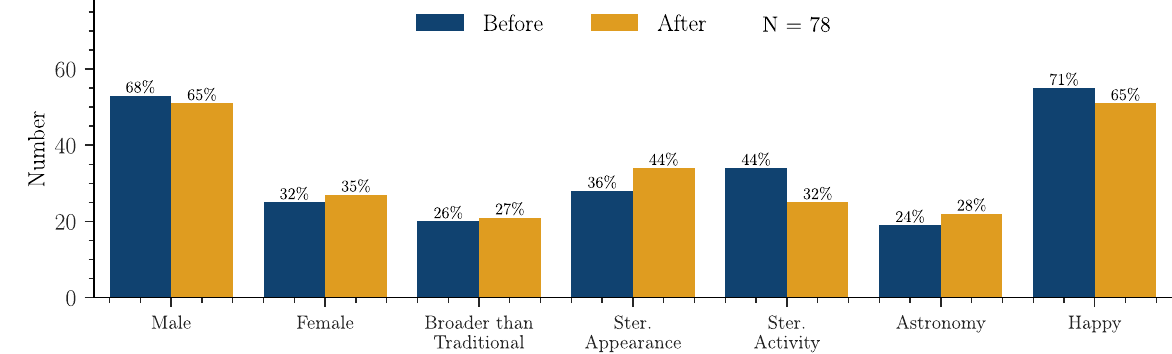
FIG. 3. Percentage of DASTs exhibiting the following symbols in our DAST grading rubric: a male scientist, a female scientist, a broader than traditional appearance of a scientist (i.e., a scientist in a nontraditional setting), a scientist with a stereotypical appearance, a scientist performing a stereotypical activity, or the presence of an astronomy related feature. These percentages are shown for both the before set of DASTs (blue) and the after set of DASTs